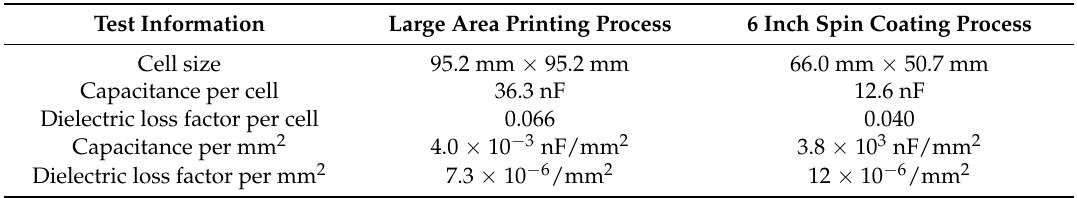
Table 1. A comparison of electrical characterization of EFD cells with engineered substrates processed by printing process and spin coating process.